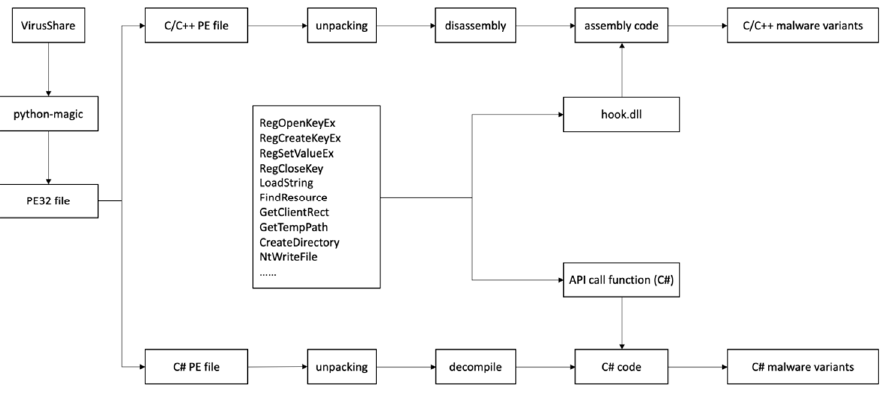
Figure 1. Malware variant construction process.